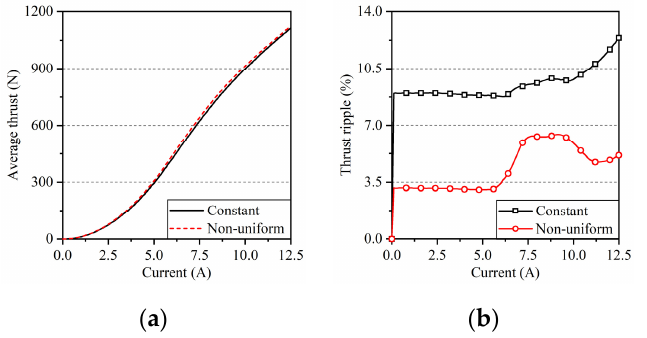
Figure 16. The overload performance ( a ) average thrust ( b ) thrust ripple of DCB-VRLMs with constant and non-uniform air gap under different currents.